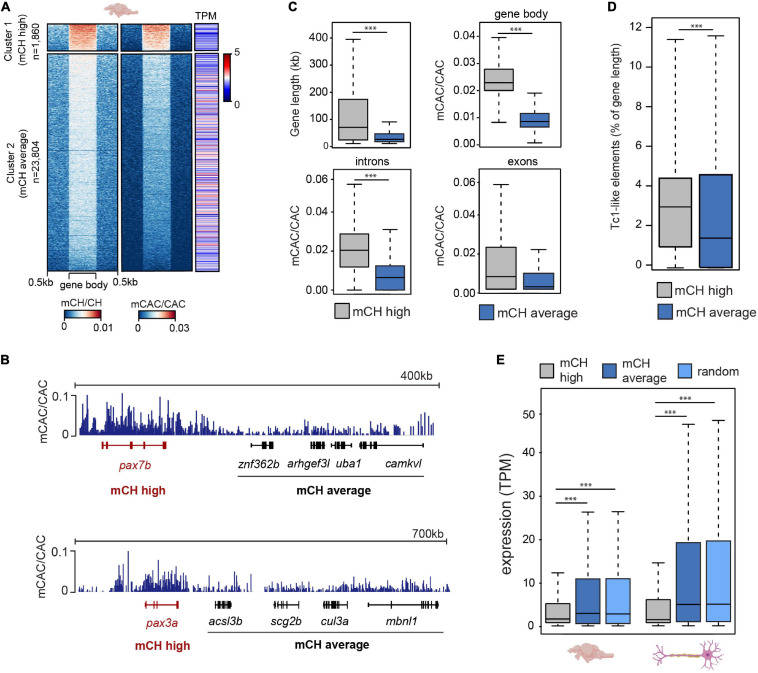
mCH is present at long genes with low expression levels. (A) mCH/CH levels, mCAC/CAC levels, and gene expression represented as transcripts per million (TPM) in adult zebrafish brains. (B) Genome browser snapshot of mCAC/CAC levels in cluster 1 (red) and cluster 2 (black) genes in adult brains. (C) Comparisons of gene length (top left), average gene mCAC/CAC (top right), average exon mCAC/CAC (bottom left) and average intron mCAC/CAC (bottom right) in genes with high (cluster 1) and moderate/low levels of mCAC/CAC (cluster 2) (Wilcoxon test, ∗∗∗P < 0.001). (D) Tc1-like element percentage of total gene length in genes with high (cluster 1) and moderate/low levels of mCAC/CAC (cluster 2) (Wilcoxon test, ∗∗∗P < 0.001). (E) Average expression levels (TPM) in 6-month old brains (n = 5) and neurons (n = 30) at genes with high (cluster 1), or moderate/low (cluster 2) mCH, and a random subset of genes (n = 1,860) sampled from cluster 2 (Wilcoxon test, ∗∗∗P < 0.001).